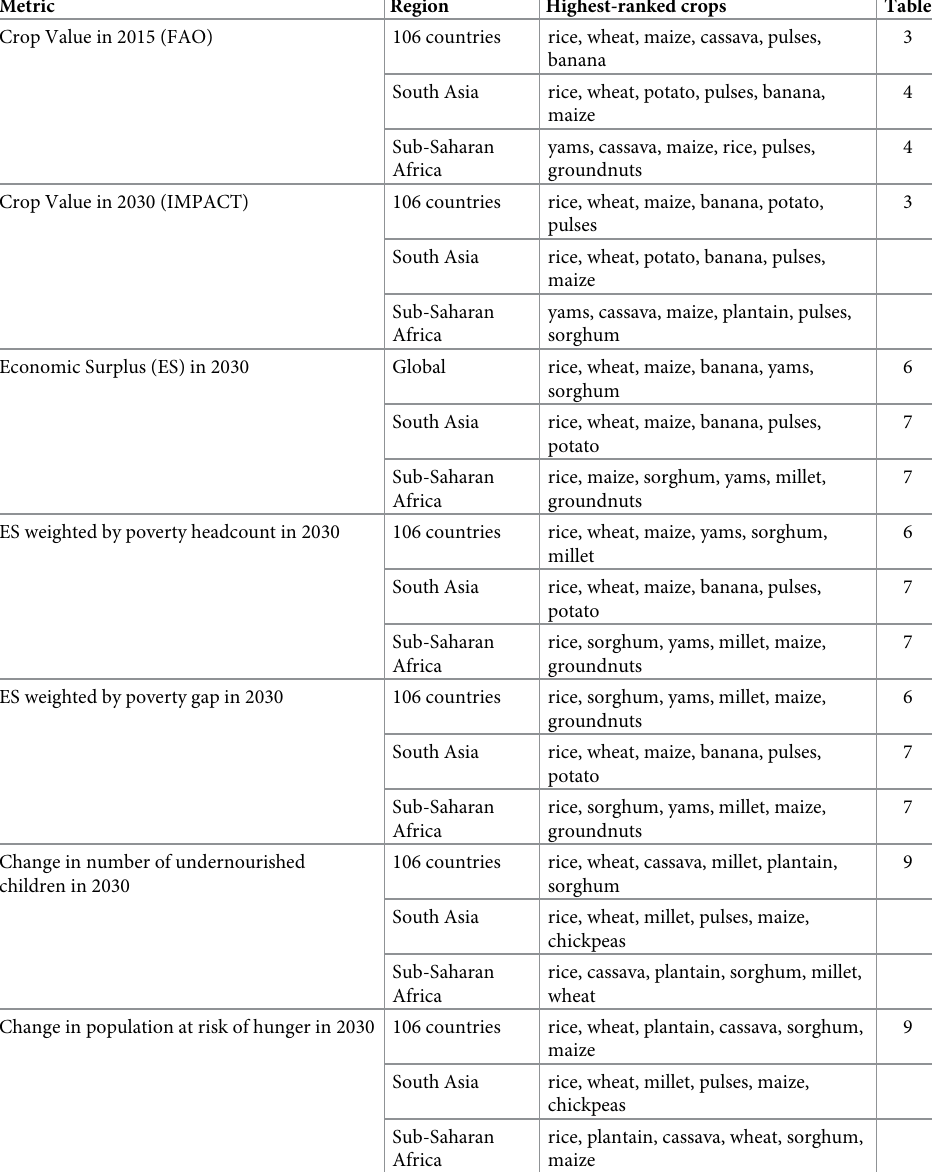
Table 11. Relative impacts of faster productivity growth on income, poverty and food security indicators: High- est-ranked crops in selected regions. Metric